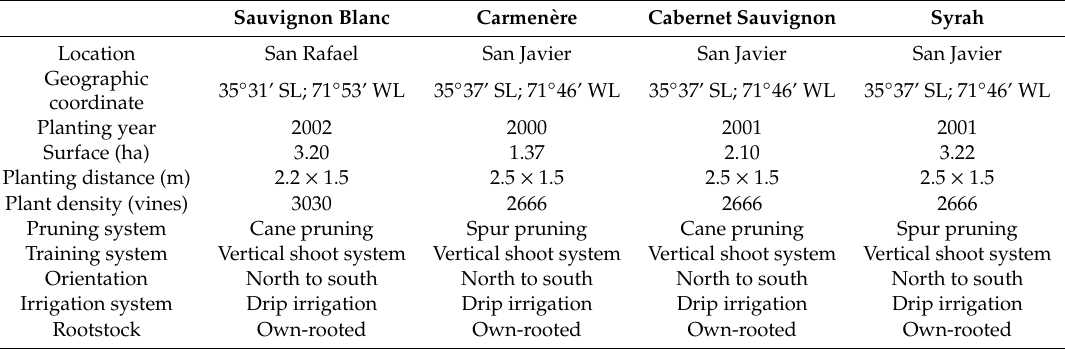
Table 1. Characteristics of the studied vineyards planted in Maule Valley (cv. “Sauvignon blanc”, “Carmen è re”, “Cabernet Sauvignon”, and